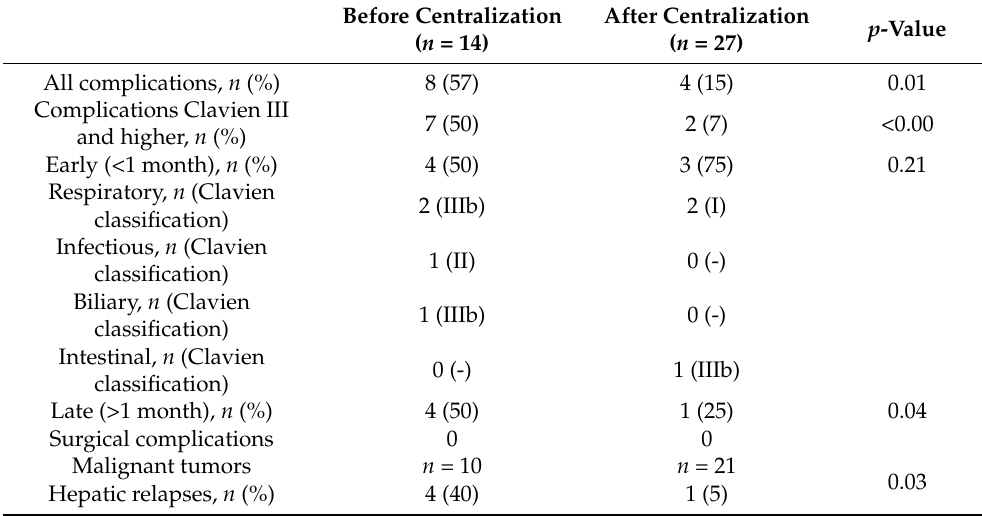
Table 3. Surgical postoperative complications and hepatic relapses before and after